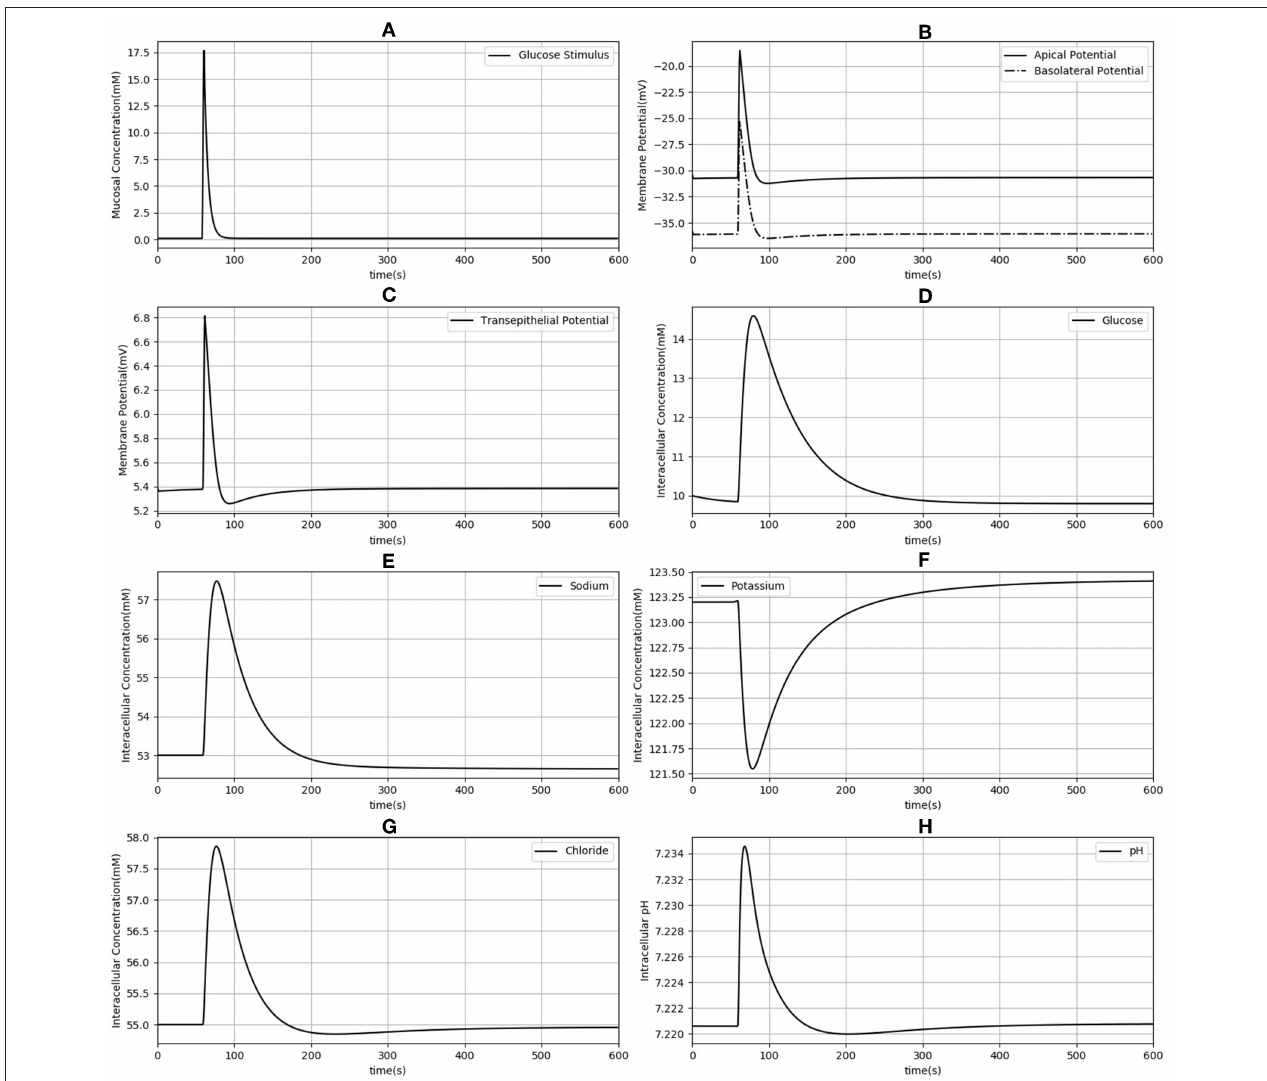
FIGURE 3 | Dynamic response of the model to an extracellular glucose stimulus. The stimulus consists of a step increase followed by an exponential decay (A) . Apical and basolateral membrane potentials (B) , transepithelial potential (C) , and intracellular concentrations of glucose (D) , sodium (E) , potassium (F) , chloride (G) , and pH (H) are shown.